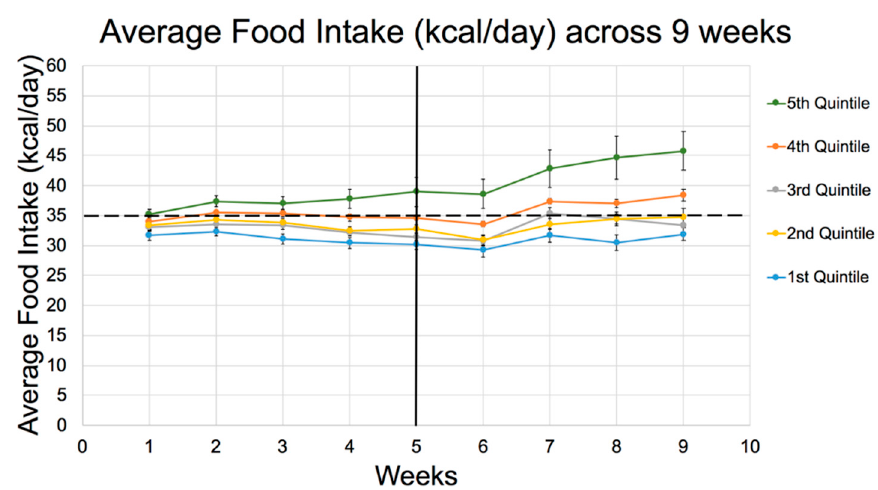
Figure 1. Food Intake (kcal/day) for 9 weeks on Diet 133 (60:20:20 CHO:fat:protein %energy) by quintiles in Experiment 2. Dotted line represents the average food intake threshold per day (35 kcal/day), exceeded only by Q4 and Q5. Q5 is also significantly greater than Q1 from the first week and all others including Q4 ( p < 0.05) from week 6 onwards. The dip in all curves at 6 weeks reflects the stress as a result of OGTT that week. See Table 4 for detailed differences between quintiles from week 1.